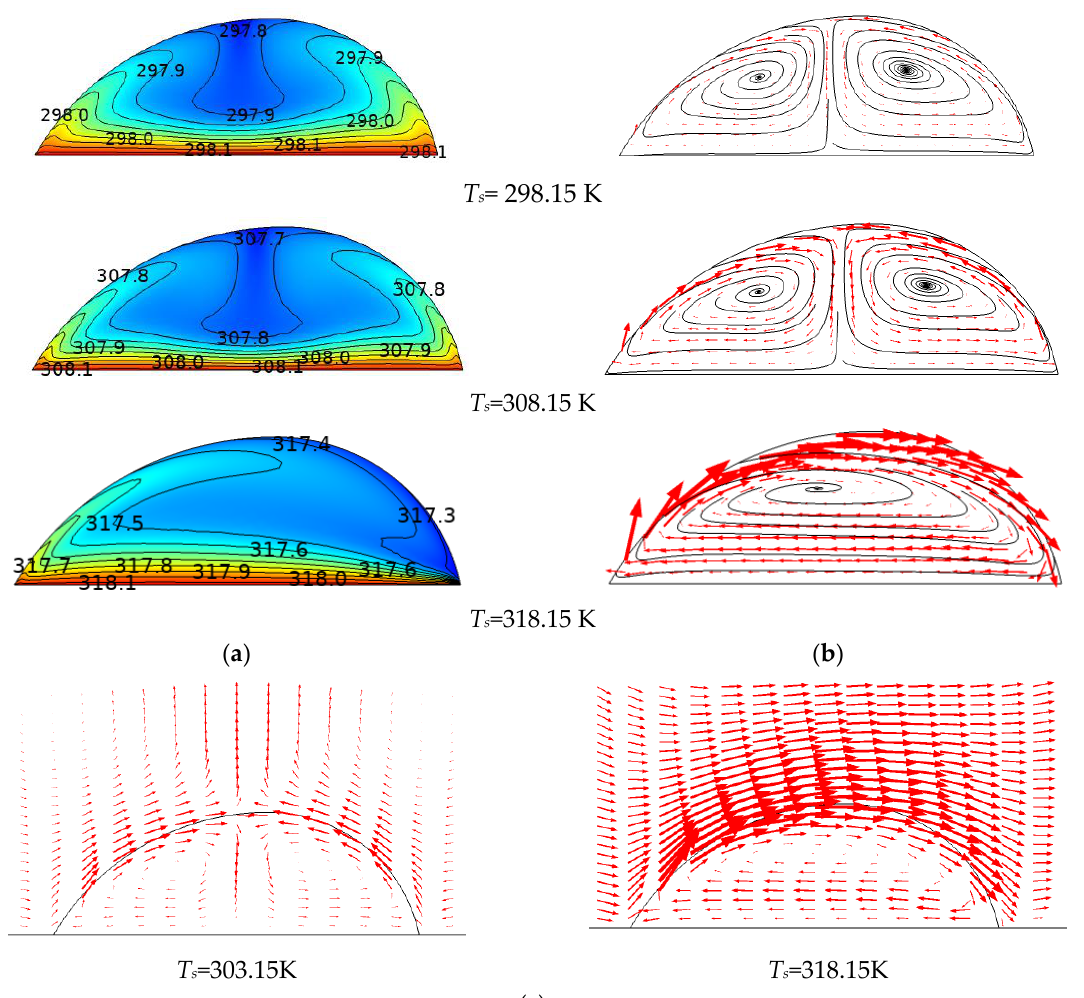
Figure 6. The evolution of the temperature and velocity at different substrate temperatures. The temperature and the velocity distribute apart in the droplet when T s = 298.15 K and 308.15 K, and a continuous distribution of temperature and a single vortex flow form when T s = 318.15 K, as shown in ( a ) and ( b ). The velocity distribution in the air acts correspondingly with the flow in the droplet, as shown in ( c ).